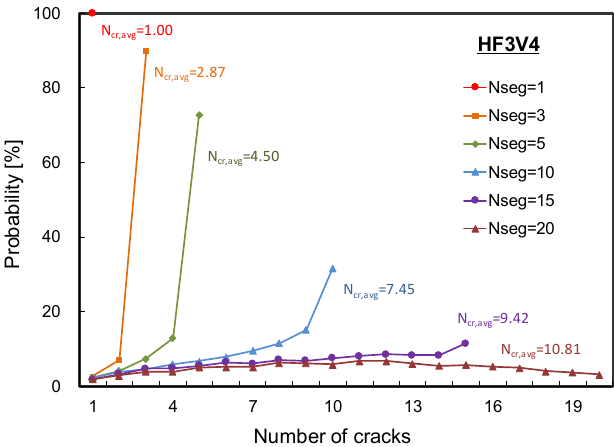
Figure 9. Probabilistic distribution on the predicted number of cracks. 328